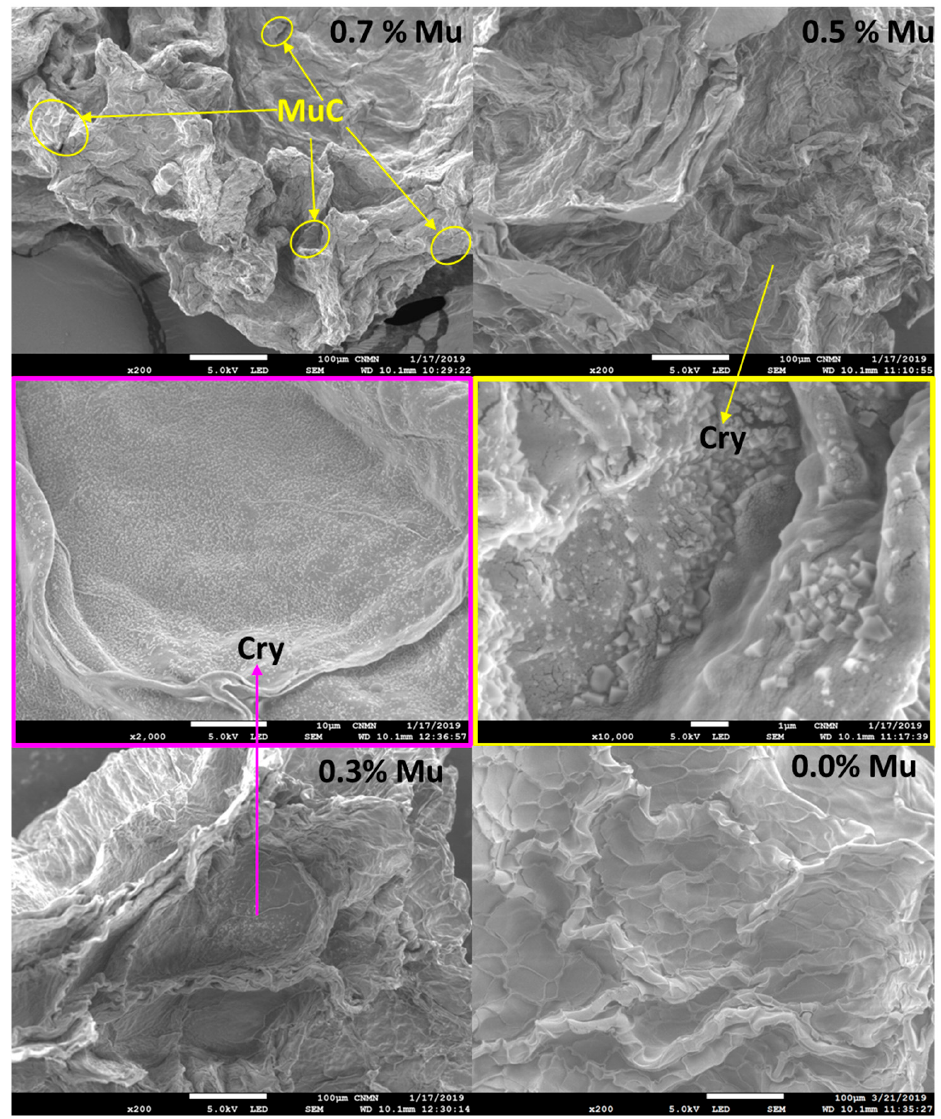
Figure 5. Microstructure of capsules matrix with mucilage–alginate. Cry (Crystal); MuC (Mucilage cells).